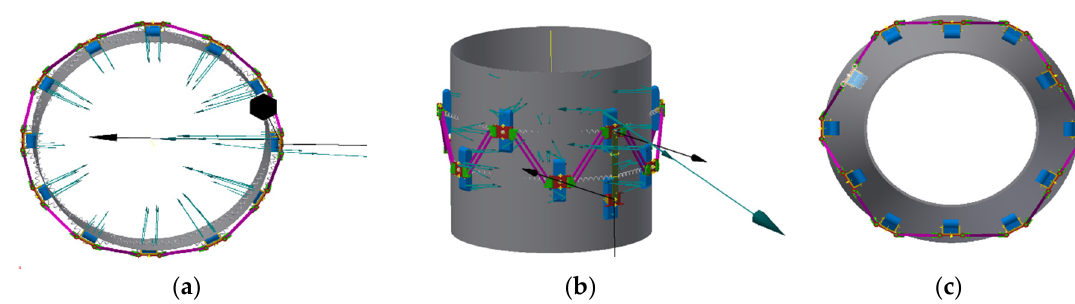
Figure 9. ADAMS Multi-Body-Dynamic Simulation: radial forces on the tower surface in top-view ( a ); radial forces side-view ( b ); set-up on a conical-shaped tower ( c ).